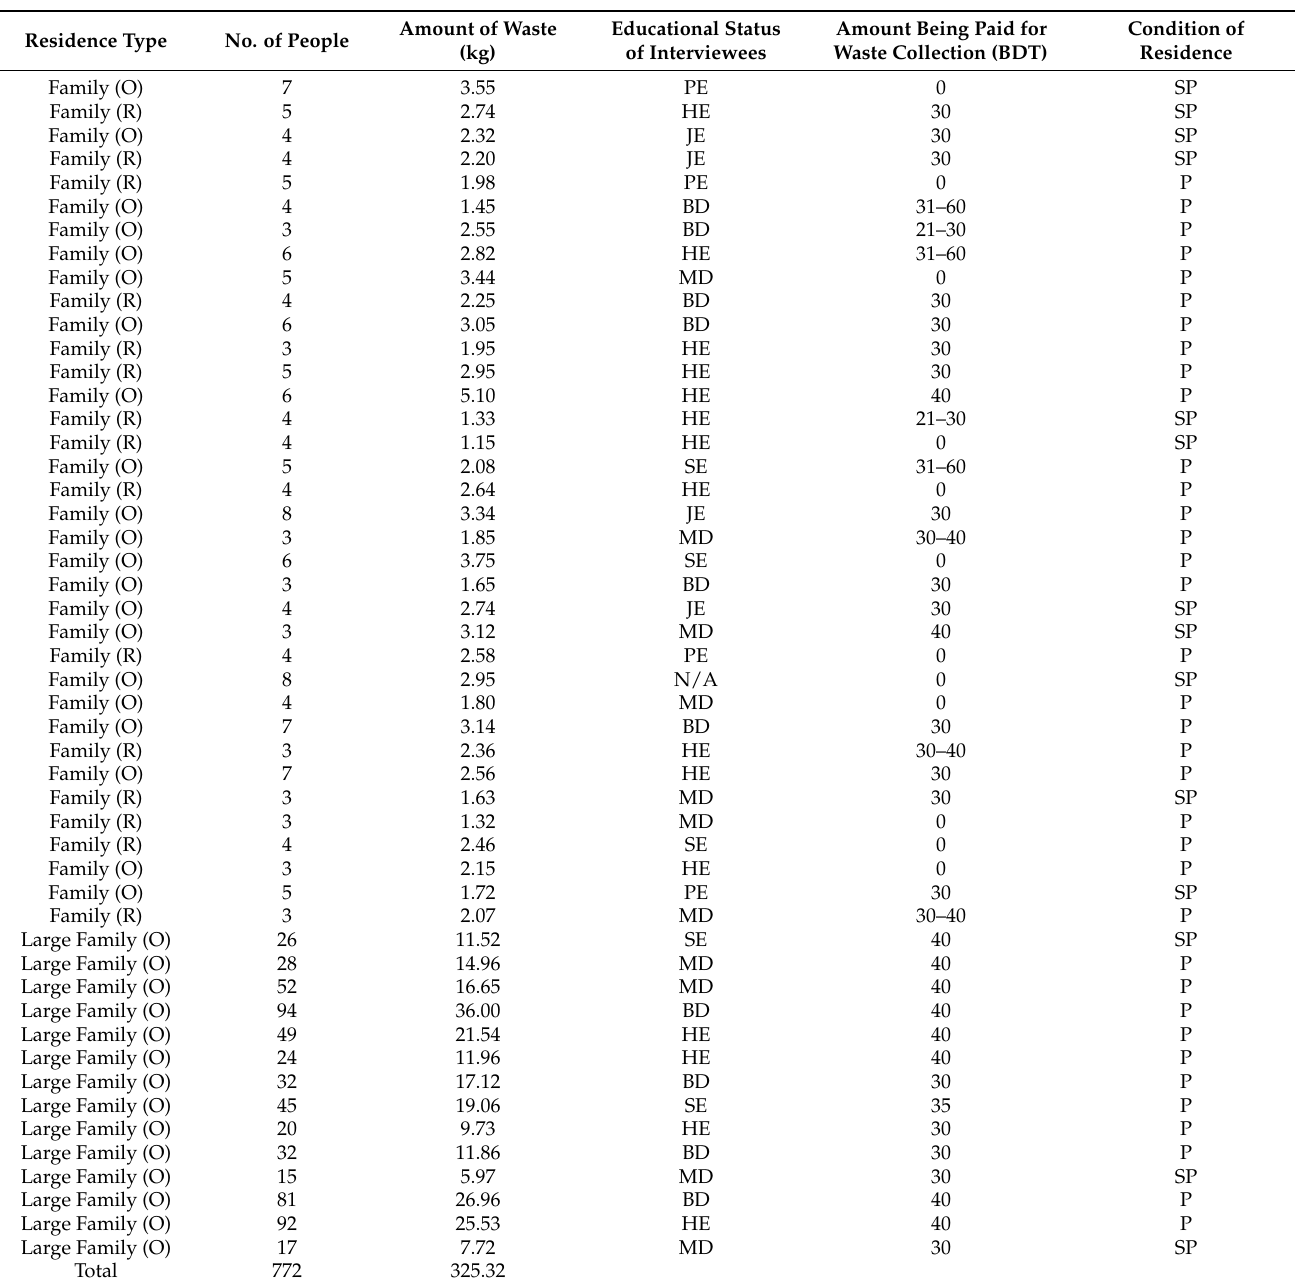
Table 5. Waste management facilities in RCC (collected from RCC authority, 2018). Waste collection data from different households in Rajshahi (O = Owned, R = Rented, PE = Primary Education, JE = Junior Education, SE = Secondary Education, HE = Higher Secondary Education, BD = Bachelor’s Degree, MD = Master’s Degree, SP = Semi-Pucca/Semi-Concrete, P =